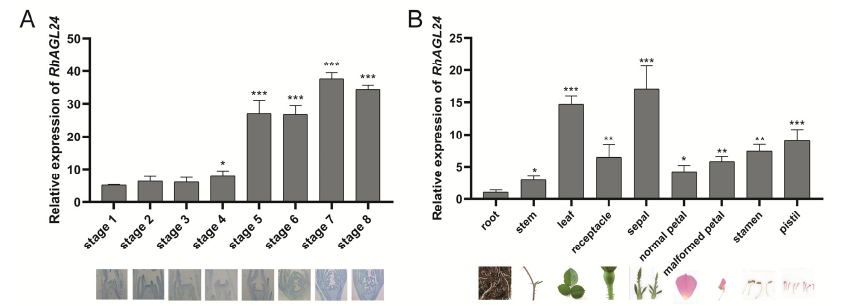
Figure 2. Expression analysis of RhAGL24 gene. ( A ) Relative expression levels of RhAGL24 at differ- ent developmental stages of floral organ primordia. One biological sample consisted of 10 floral buds at any stage. All the values are the means ± SD of three biological replicates. Stage 1—vegeta- tive development; stage 2—prophase of transition from vegetative growth to reproductive growth; stage 3—transition from vegetative growth to reproductive growth; stage 4—sepal primordia dif- ferentiation; stage 5—petal primordia differentiation; stage 6—stamen primordia differentiation; stage 7—pistil primordia differentiation; stage 8—completion. ( B ) Relative expression levels of RhAGL24 in different plant organs. All the values are the means ± SD of three biological replicates.